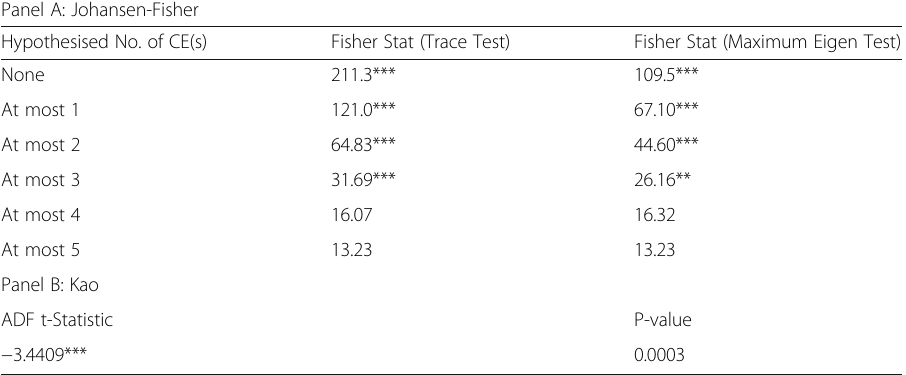
Table 7 Panel cointegration test (Johansen-Fisher and Kao) Panel A: Johansen-Fisher Hypothesised No. of CE(s) Fisher Stat (Trace Test) Fisher Stat (Maximum Eigen Test) None 211.3*** 109.5*** At most 1 121.0*** 67.10*** At most 2 64.83*** 44.60*** At most 3 31.69*** 26.16** 16.07 16.32 13.23 13.23 Panel B: Kao ADF t-Statistic P-value 0.0003